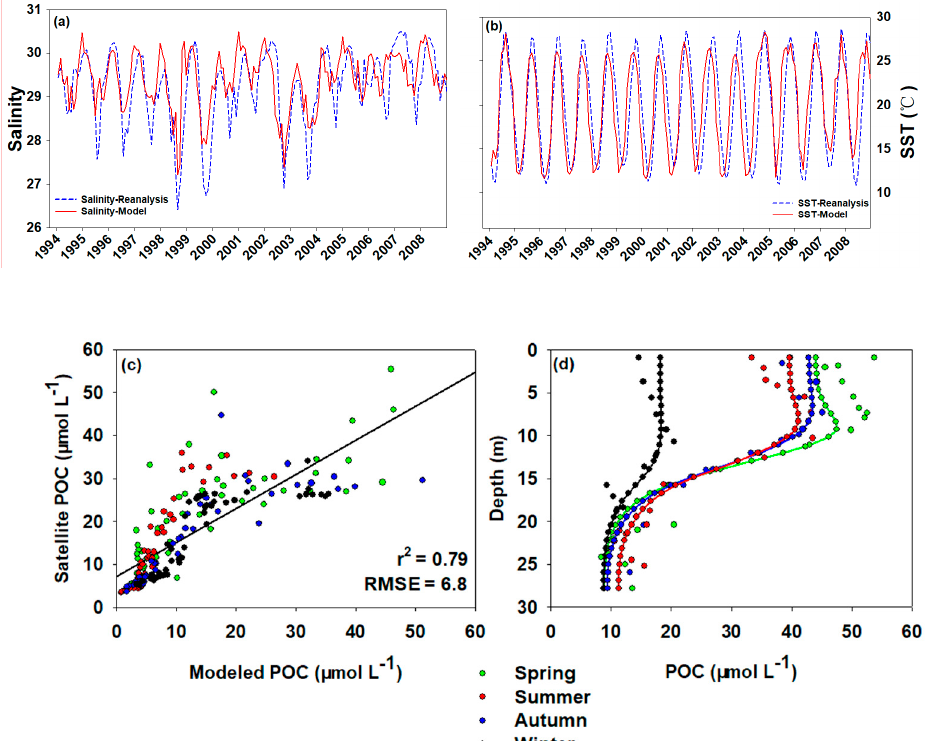
Figure 3. Comparison of reanalysis, satellite, and in situ data with our model results. ( a , b ) represent long time variation of sea surface salinity and temperature, respectively. ( c ) indicates the correlation analysis of satellite and modeled data in the surface layer. In ( d ), the solid lines represent the modeled data, while the colored dots represent in situ data of the vertical distribution.